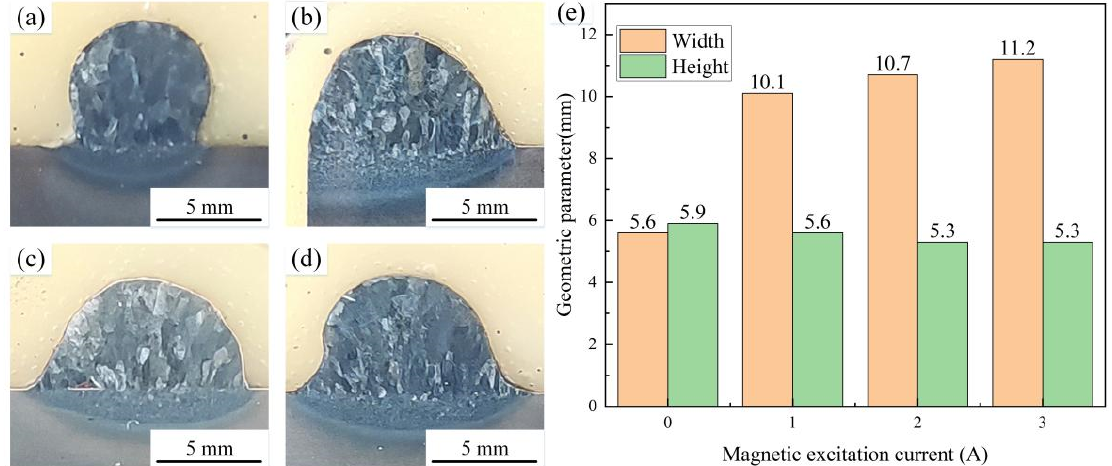
Figure 7. Cross-sectional morphology of the deposition layer with short-circuiting transfer. (Note: ( a ) MIG, ( b ) M-MIG with magnetic excitation current of 1A, ( c ) M-MIG with magnetic excitation current of 2A, ( d ) M-MIG with magnetic excitation current of 3A, ( e ) The geometric parameter of the cross-sectional morphology)